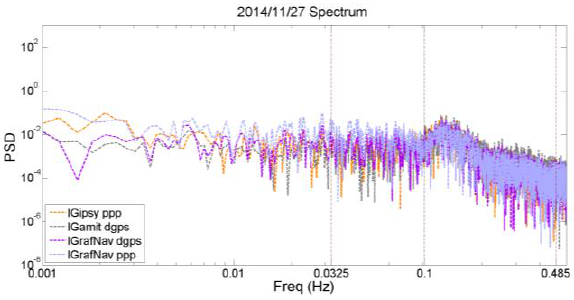
Figure 11(c). FFT power spectrum of integration solutions